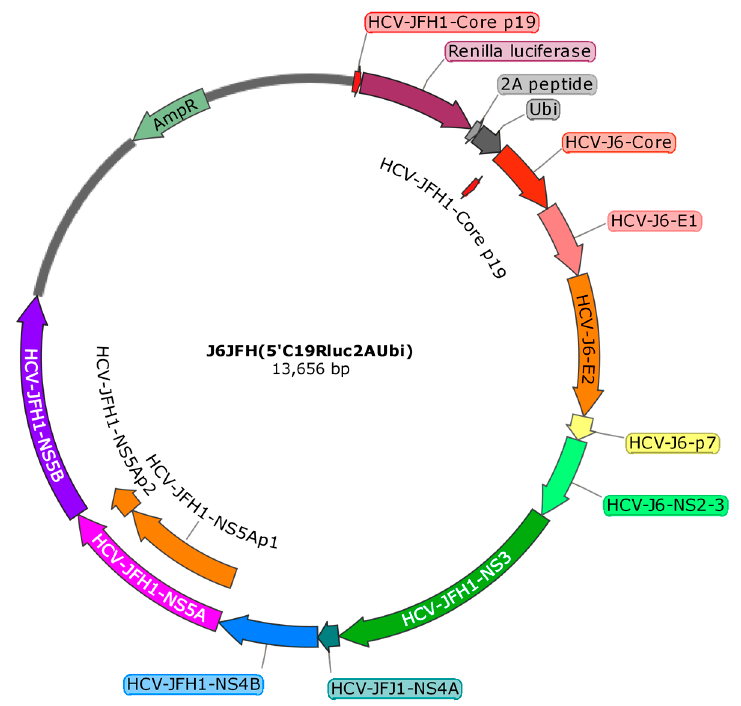
Figure 6. Scheme of the HCV reporter construct J6JFH (5 ′ C19Rluc2AUbi).